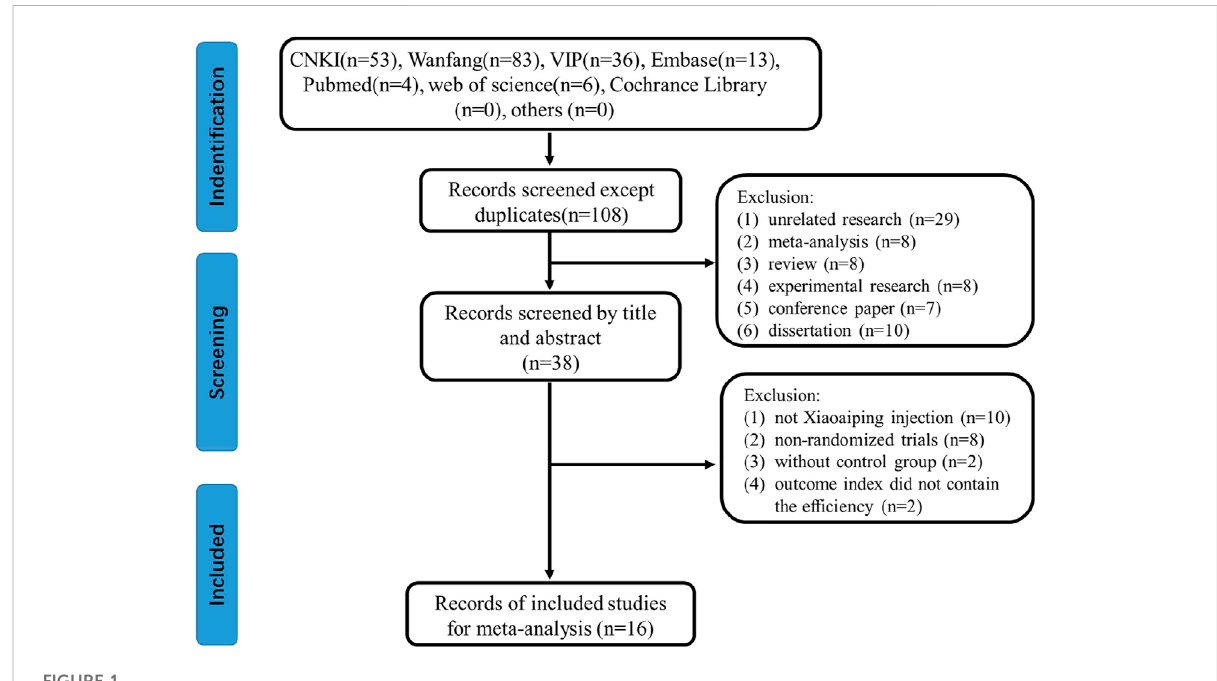
FIGURE 1 PRISMA fl ow diagram of this